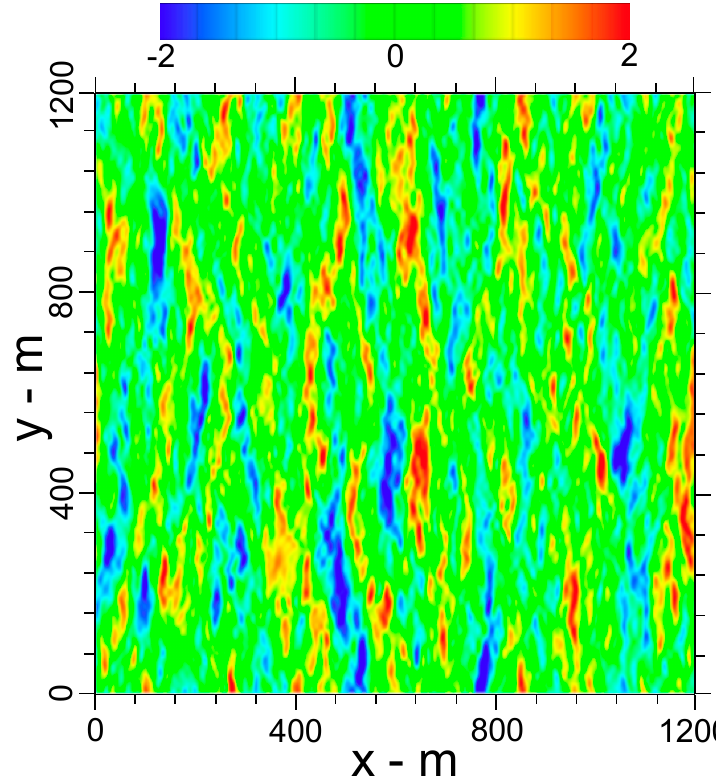
Figure 33. Wave simulation using input radar data and the algorithm in the flow chart in Figure 16 extended to two dimensions. See Osborne [1] for additional numerical methods.